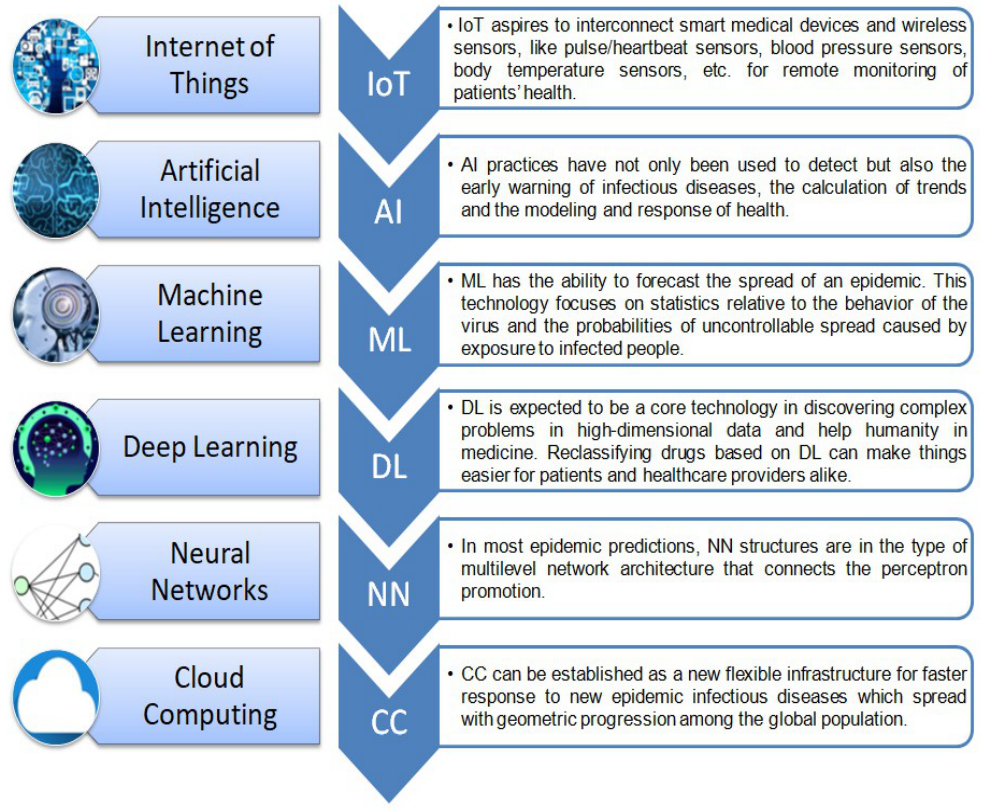
Figure 1. The emerging technologies used in our proposed system.